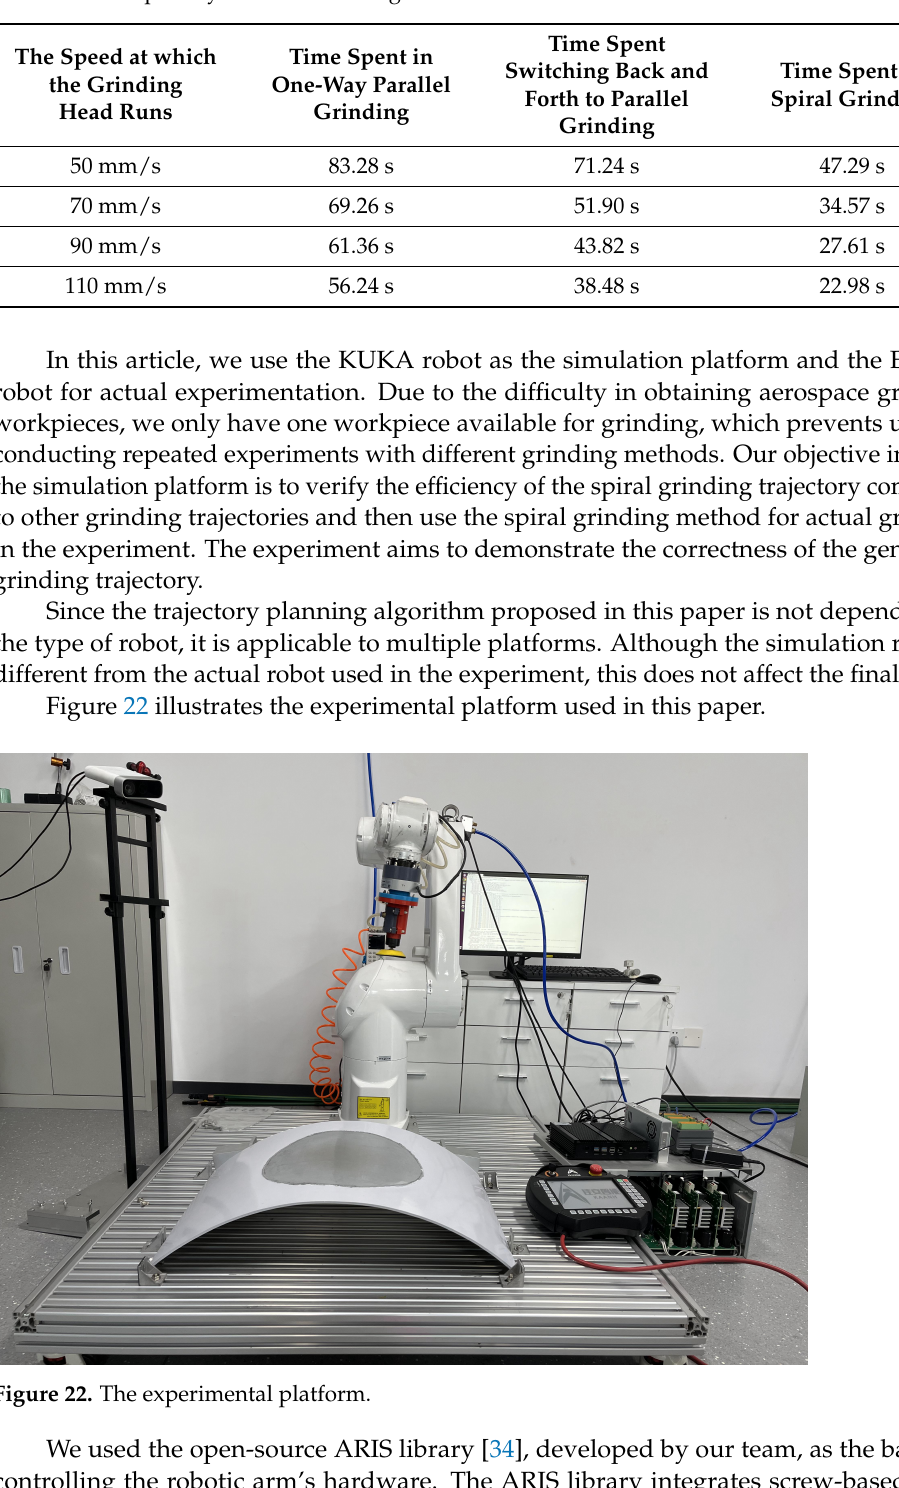
Table 1. Time Spent by Different Sanding Methods.